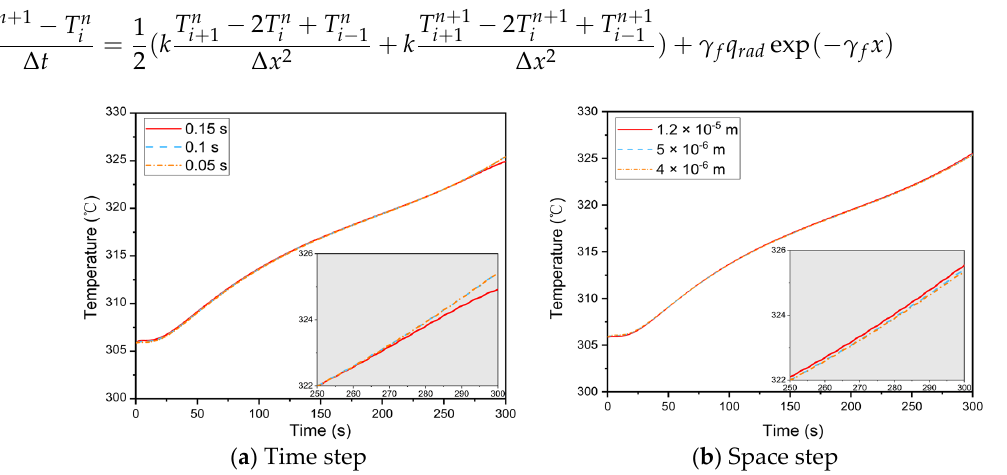
Figure 4. Simulation results of the grid independence study.